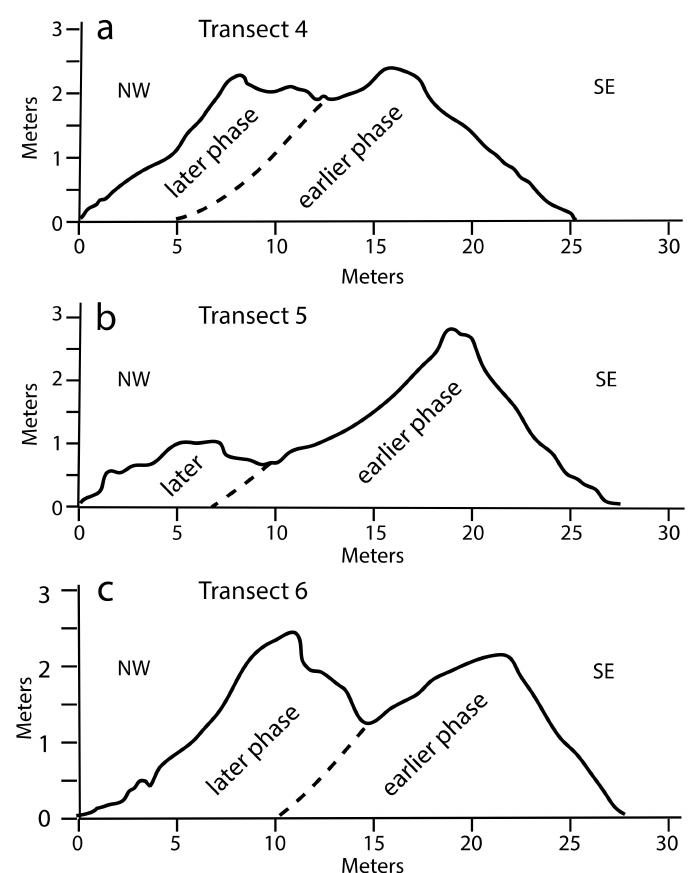
Figure 9. Comparison of selected transverse profiles in the distal part of the spit showing separation of di ff erent phases in the overall deposit. Transects 1–3 and 7 lack such distinct features; ( a ) Elevation profile through transect 4; ( b ) Elevation profile through transect 5; ( c ) Elevation profile through transect 6. See Section 3 for source of the elevation